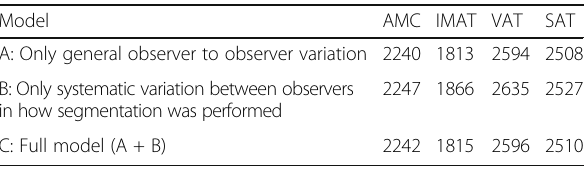
Table 2 Model fit evaluated by Akaike information criterion (AIC) for three mixed effects models